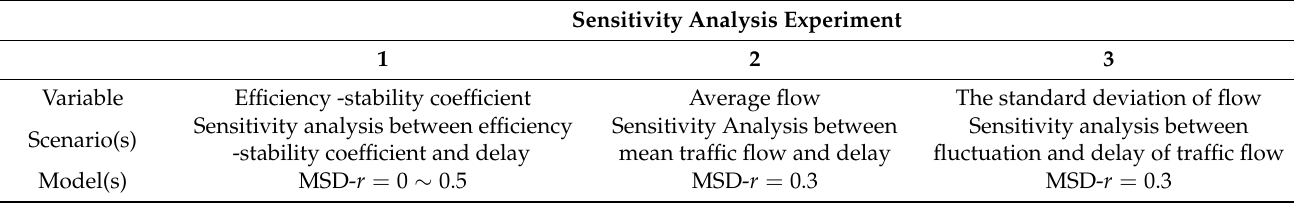
Table 4. Sensitivity analysis experimental